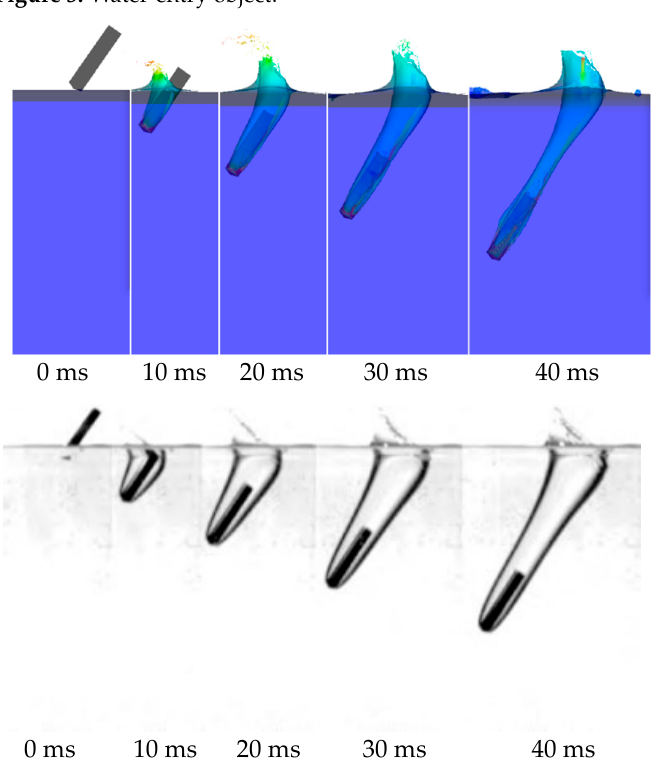
Figure 4. Calculated results of velocity magnitude and high-speed photographs from experiments.